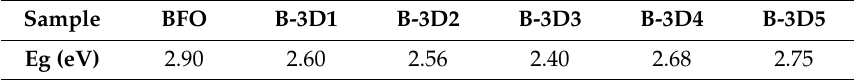
Table 1. The band gaps of 3D BFO/graphene